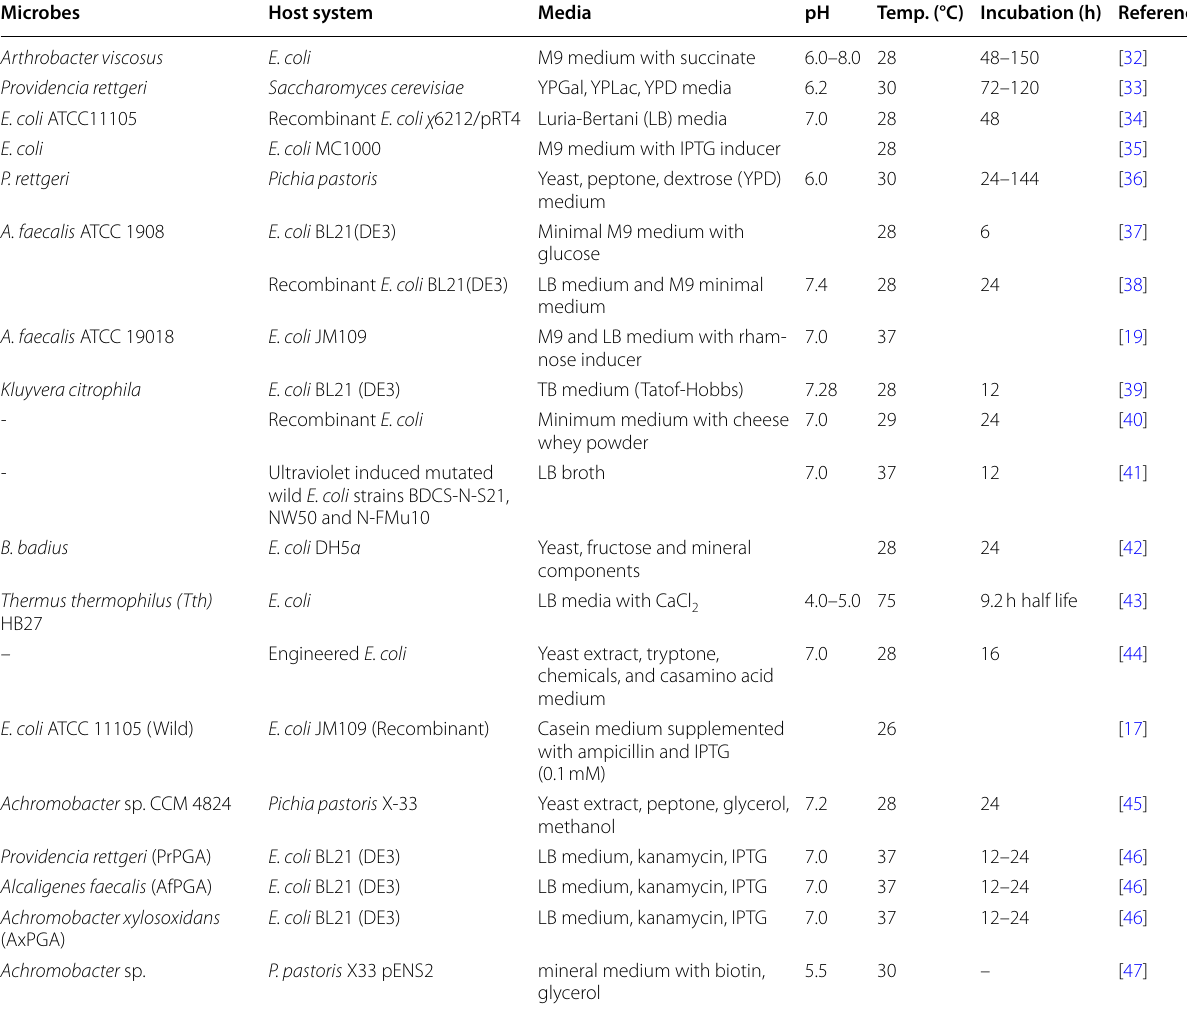
Table 2 Production kinetics of PGA producing recombinant strains